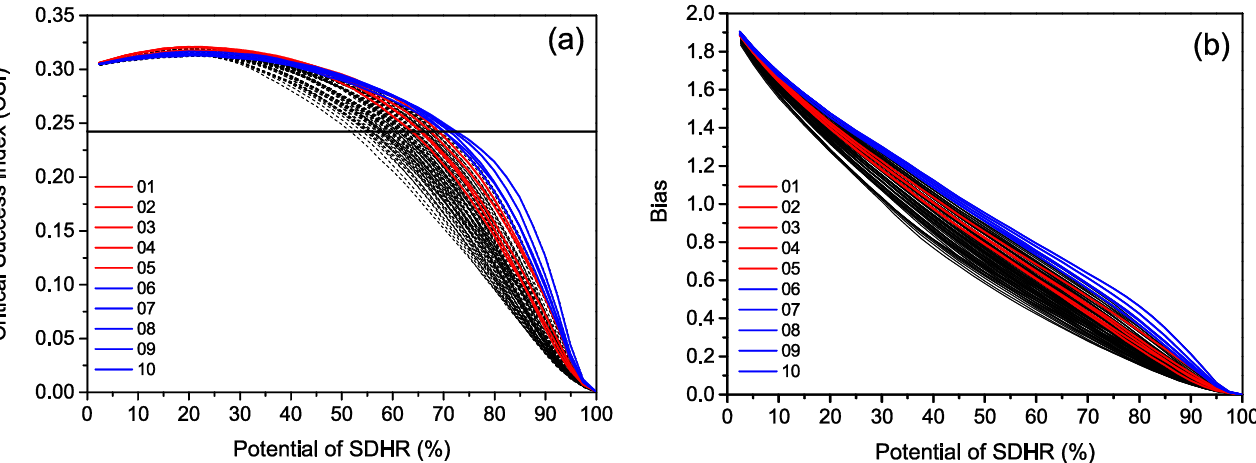
Figure 5. Variation of ( a ) CSI and ( b ) bias for the 00–12 h probability of SDHR with different weight settings. The 12-hour operational SDHR forecasts issued at 08:00 BT (horizontal black line in Figure 5a) during the 2015 warm season are shown for reference. The five red lines are the top groups with the highest maximum CSI, and the blue lines represent the top five groups with the highest maximum CSI ave . The weights of the ten groups are listed in Table 4. Table 4. Weights of groups with the maximum CSI and CSI ave for the 00–12 h forecast. No. 1–5 are listed with maximum CSI, while NO. 6–10 are listed with maximum CSI ave . No. 11 in the group is assigned with equal weights. The Bias, POD, and FAR that correspond to the CSI are also given. The maximum CSI and CSI ave are bolded. The maximum weight values of each group are also bolded.